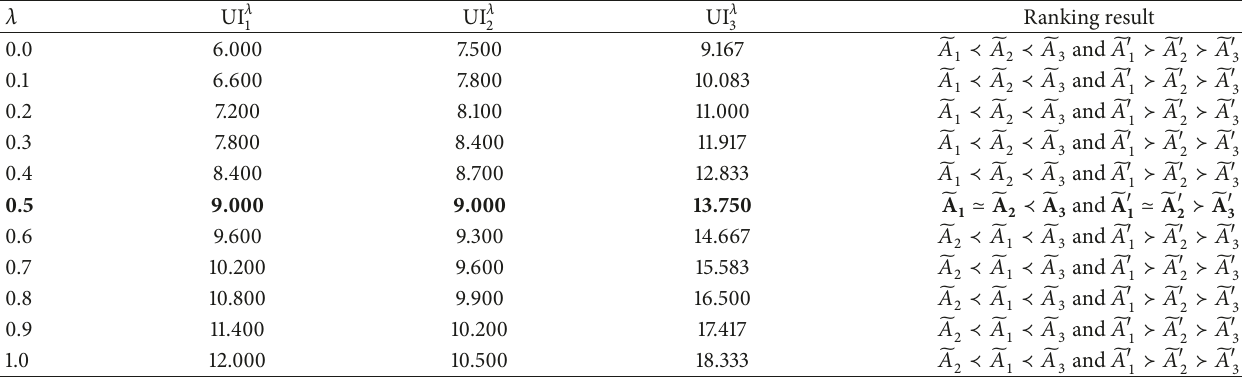
Table 4: Ranking results at different optimism levels in Example 17.